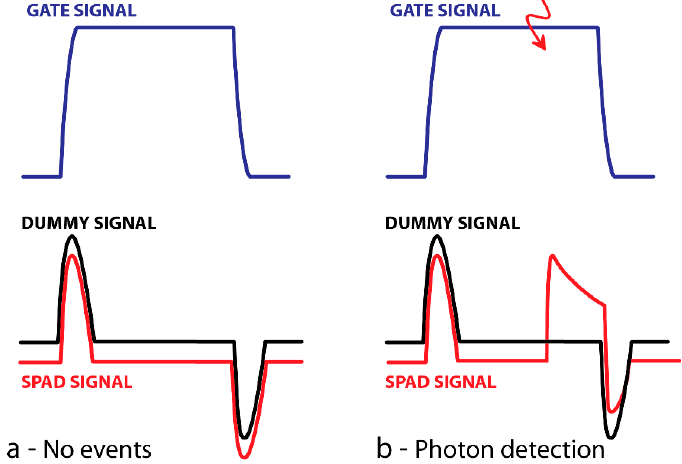
Figure 8. Gate voltage signal (blue line) provided to the SPAD front-end circuit of Figure 7 and resulting SPAD voltage signal at the positive input of the comparator (red line) without photon detection ( a ) and with a single-photon detection ( b ) [31]. The red arrow indicates the arrival delay of a photon inside the gate. Dummy voltage signal (black line) generated by providing the same gate signal to a capacitor that only mimics the SPAD parasitic behavior, without being able to detect photons. If the dummy signal is provided to the negative input of the comparator of Figure 7: ( a ) SPAD and dummy signal do not cross, thus avoiding triggering the comparator and the following timing electronics when no avalanche occurs; ( b ) the SPAD signal exceeds the dummy signal when the photon is detected, thus forcing the comparator to switch, triggering the following timing electronics. A more detailed discussion of these waveforms can be found in [31,66].